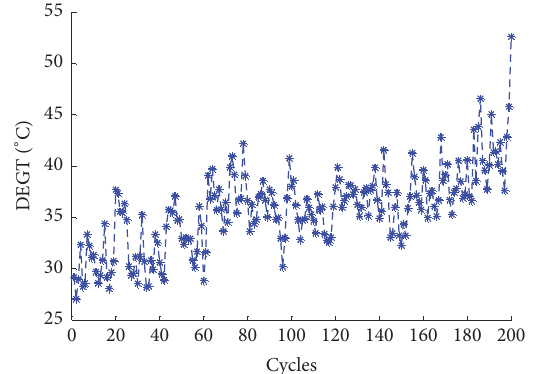
Figure 7: True values in evaluation of DEGT prediction accuracy.